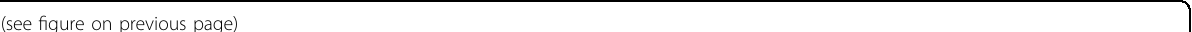
Fig. 3 Depression of DANCR inhibits metastasis and HSP27 expression in CRC cells HT29 and LOVO. a The metastasis ability of HT29 and LOVO cells was inhibited after the depression of DANCR, as detected by Transwell assays (Scale bar = 200 µm; magni fi cation, ×20). b Depression of DANCR inhibited the metastasis ability of HT29 and LOVO cells, as detected by wound-healing assays (Scale bar = 500 µm; magni fi cation, ×4). c HSP27 was gradually elevated with progressed staging of CRC as detected by IHC. *** P < 0.001 vs. the clinical stage I group. d Depression of DANCR inhibited HSP27 expression in HT29 and LOVO cells, as detected by western blotting and qRT-PCR. ** P < 0.01 vs. the NC shRNA group. The data are shown as the means ± SD from three independent